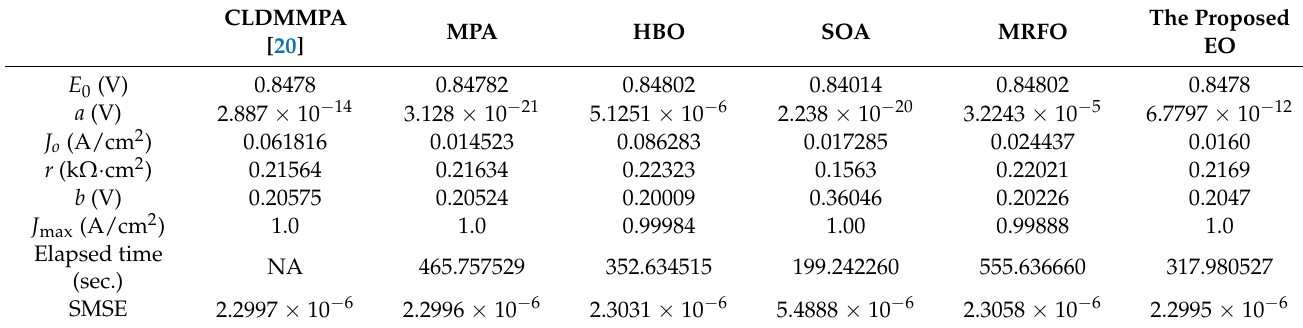
Table 4. The optimal parameters of SOFC steady-state based model operated at 1273 K.